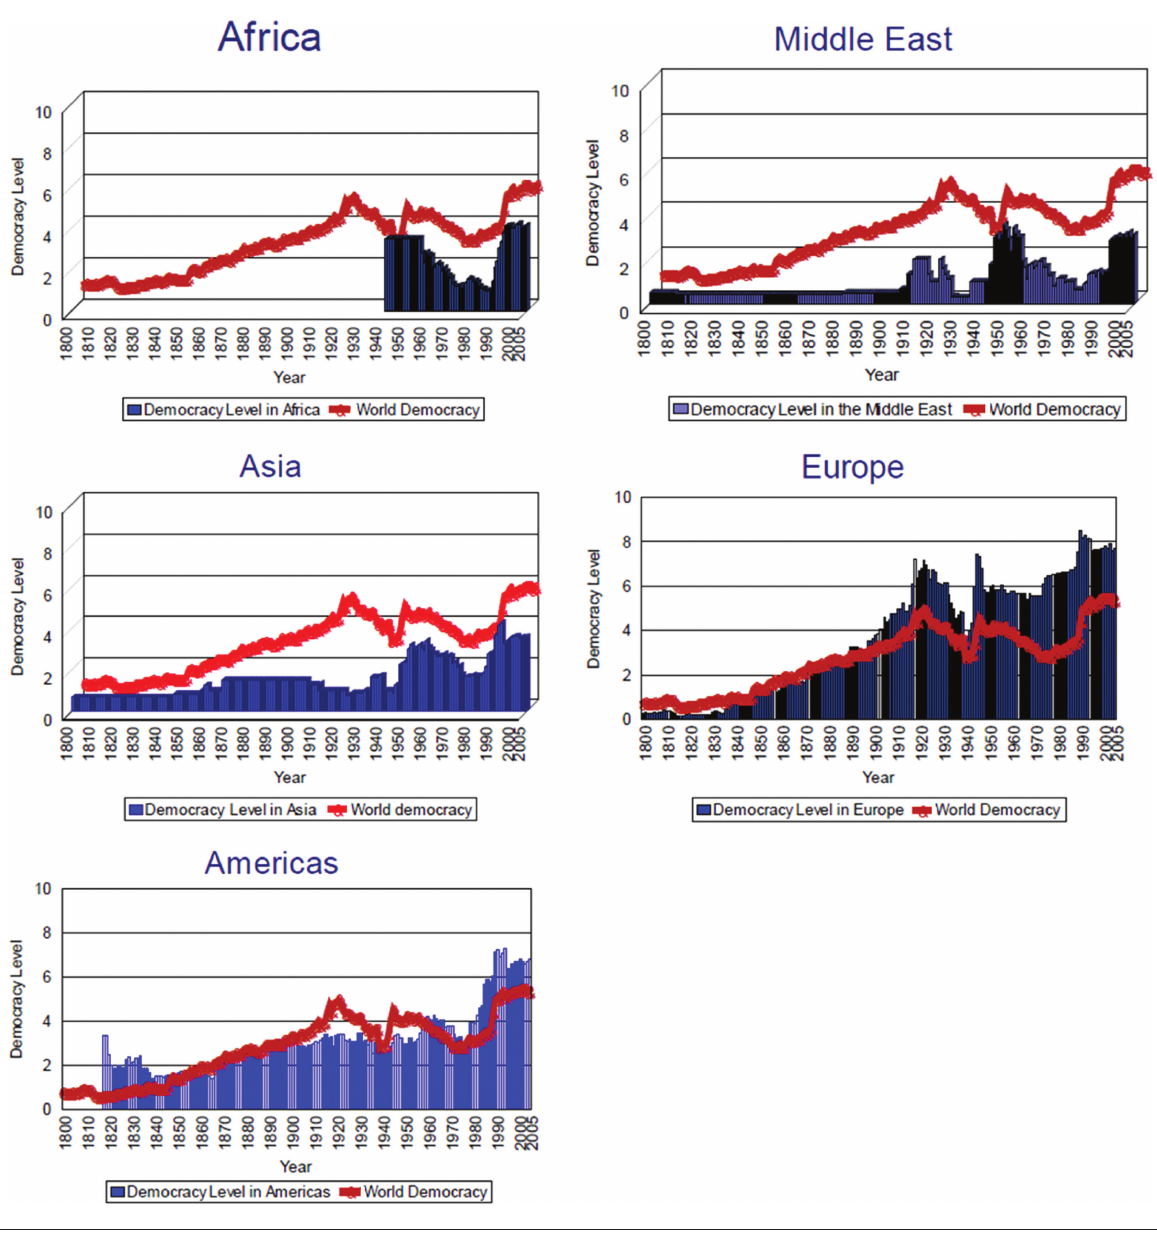
Figure 3. Mean level of democracy across regions as compared to the worldwide democracy level, 1800–2005. Note: The number of countries in this figure varies across time in each region of the